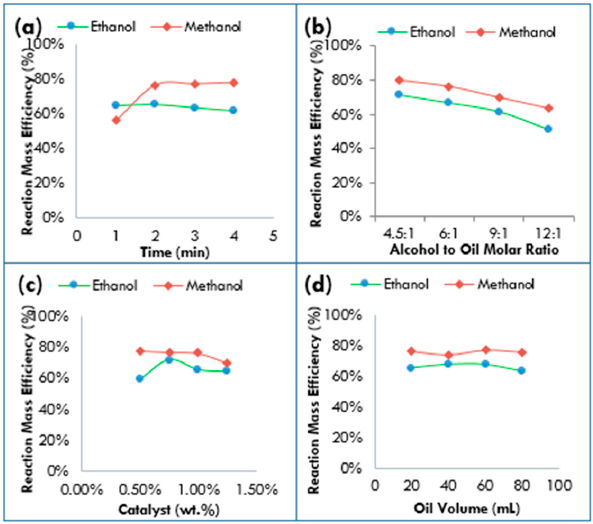
Figure 6. Reaction mass efficiency for the simultaneous effect of MW/US in WCO transesterification. Effect of ( a ) different reaction time; ( b ) alcohol to oil molar ratio; ( c ) catalyst concentration and ( d ) sample (oil) volume.